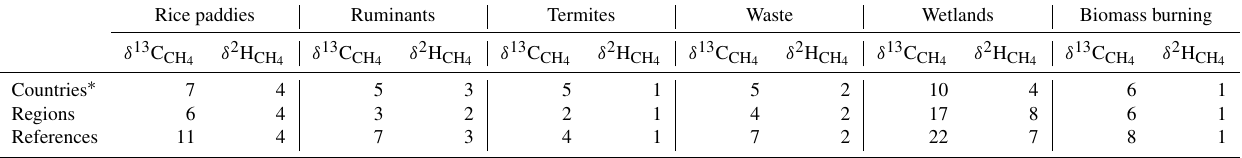
Table 4. Non-fossil data: number of countries, regions, and references by source and specified chemical parameter. Rice paddies Ruminants Termites Waste